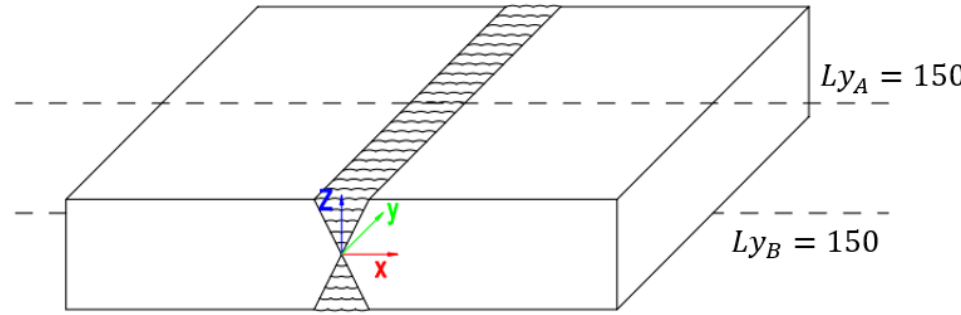
Figure 11. The transverse direction through the center of the weld seam (mm).